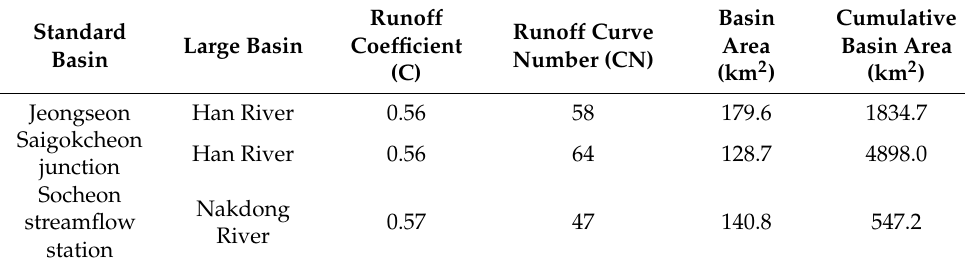
Table 2. General characteristics of basins.